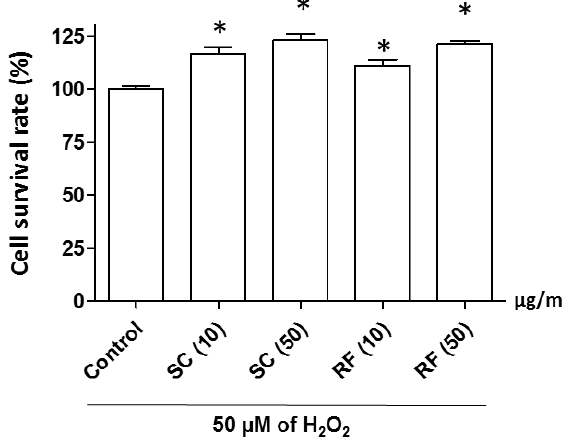
Figure 2. Effect of Schisandra chinensis (SC) and Ribes fasciculatum (RF) extracts on cell survival rate. SC and RF were extracted with 30% ethanol and PC12 neuronal cells were treated with SC and RF extracts at 10 or 50 μg /mL. The protective effect of SC and RF extracts were measured by the WST assay. Control is a treatment of 50 µM of H 2 O 2 . *: p < 0.05 vs. control.